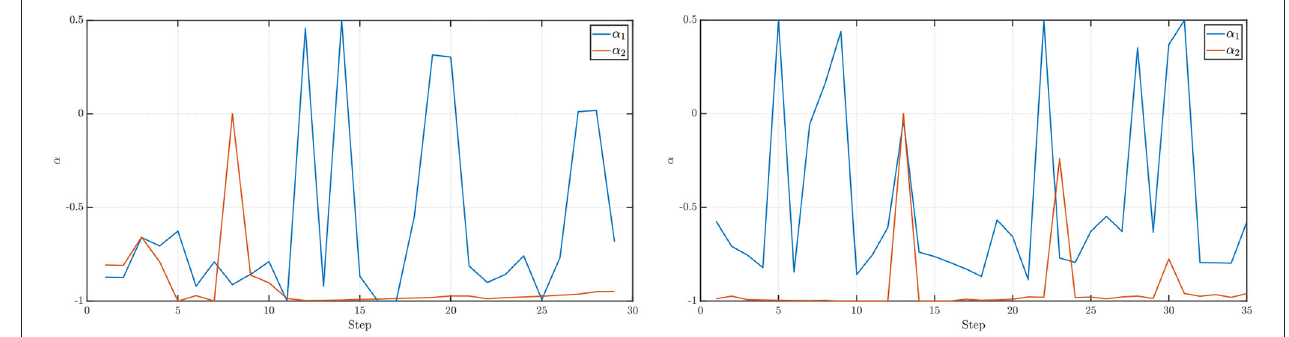
FIGURE 4 | ( Left ) Values of the fractional differencing parameter α 1 (along the x -axis) and α 2 (along the y -axis) as estimated by the Whittle estimation procedure for the example presented in Figure 3 (left). ( Right ) Values of the fractional differencing parameter α 1 (along the x -axis) and α 2 (along the y -axis) as estimated by the Whittle estimation procedure for the example presented in Figure 3 (right).